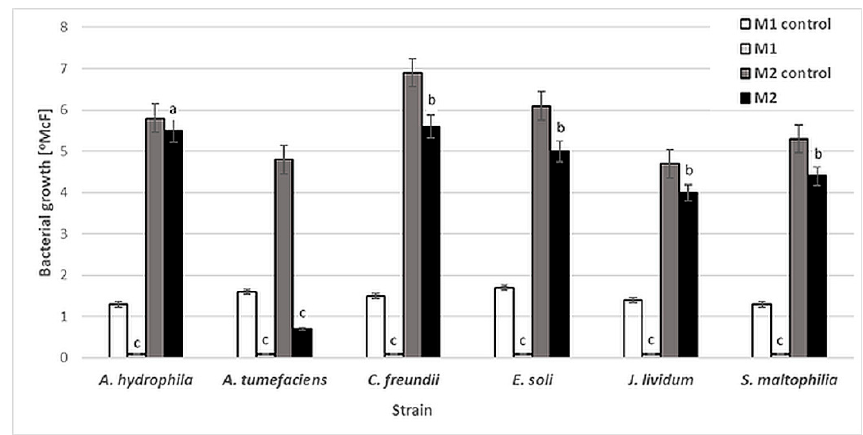
Figure 1. Growth [°McF] of bacterial strains in minimal M1 and rich M2 culture media in the presence of 0.25% ( w / v ) NAC in comparison to that for control samples (without NAC). Values show the mean ± standard deviation (SD, n = 3). The results are compared to those of the control samples (without NAC). Values with different letters are statistically different: a, p ≥ 0.05; b, 0.005 < p < 0.05; c, p < 0.005.